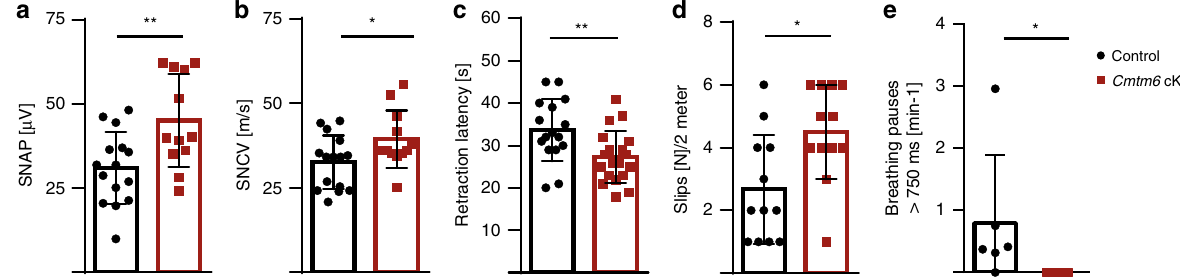
Fig. 3 Electrophysiological properties and behavioral performance of mice lacking CMTM6 from Schwann cells. a , b Electrophysiological measurement reveals a larger sensory nerve action potential (SNAP) and accelerated sensory nerve conduction velocity (SNCV) in the tails of Cmtm6 -cKo compared to control mice at P75. n = 15 control and n = 12 Cmtm6- cKo mice; a P = 0.0061 and b P = 0.0386 by two-tailed Student ’ s t -test. c The latency of retracting a hindlimb upon a heat stimulus was reduced in Cmtm6 -cKo compared to control mice. n = 16 control and n = 19 Cmtm6- cKo mice; P = 0.0089 by two-tailed Student ’ s t -test. d Compared to control mice, Cmtm6- cKo-mice showed an increased number of fore- and hindlimb slips while traveling a distance of 2 m on a regular grid. n = 12 mice per genotype; P = 0.0111 by two-tailed Student ’ s t -test. e Cmtm6- cKo-mice did not show breathing pauses longer than 750 ms. n = 6 mice per genotype; P = 0.0152 by two-sided Mann – Whitney rank-sum test. Data presented as mean ± SD; * P < 0.05; ** P < 0.01. Source data see Source Data fi